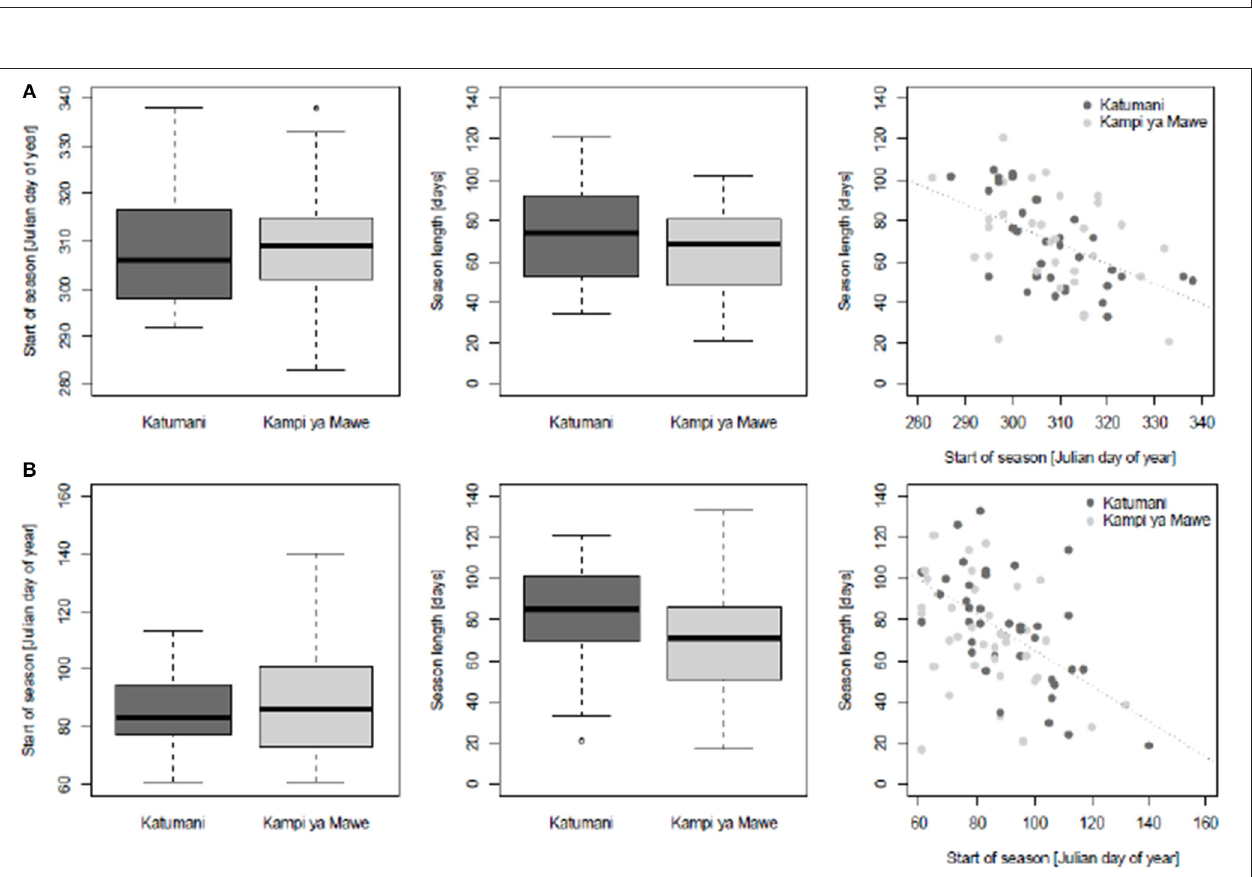
FIGURE 3 | Boxplots representing characteristics of growing season length in Katumani and Kampi ya Mawe, Eastern Kenya, including start of growing season (day of the year, DOY) and growing season length (days) as well as the relationship between start of growing season and growing season length for the short rain (A) and the long rain (B) season according to data as described in Table 1 .